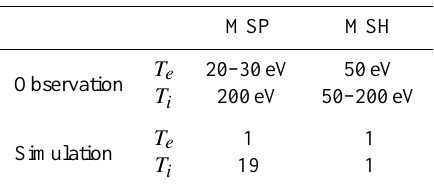
Table 1. Comparison of ion and electron temperatures, the observed case versus the simulation. MSP MSH T e Observation